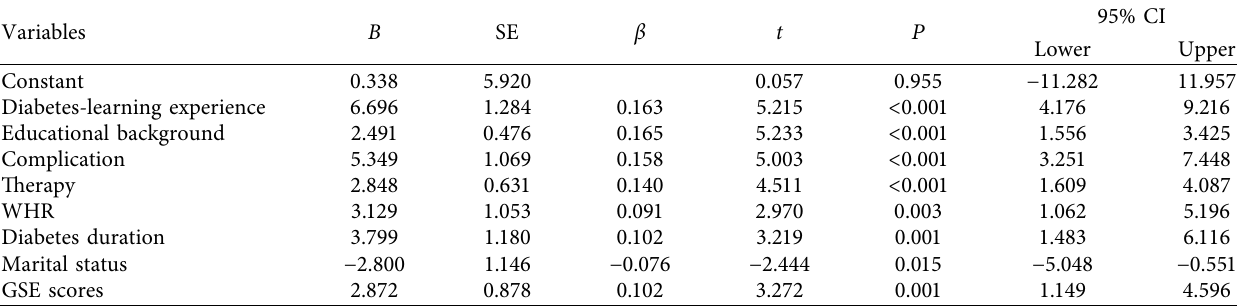
Table 6: Multivariable linear regression analysis of diabetes